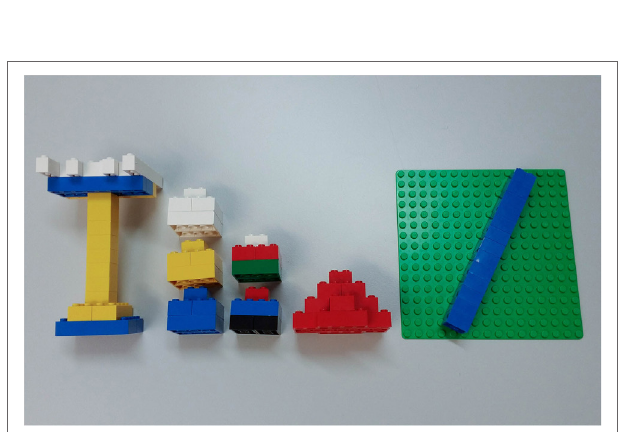
FigUre 1 | study setup with the participant interacting with the robot and two researchers seated behind a bookshelf who supervised the technology .